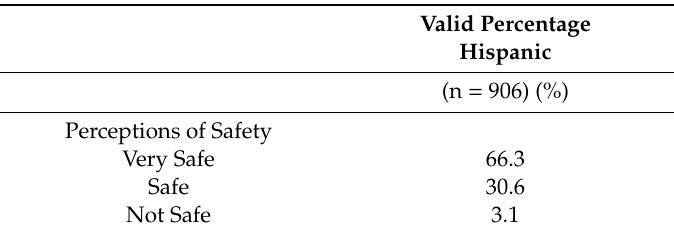
Table 2. How safe do you feel in your neighborhood?